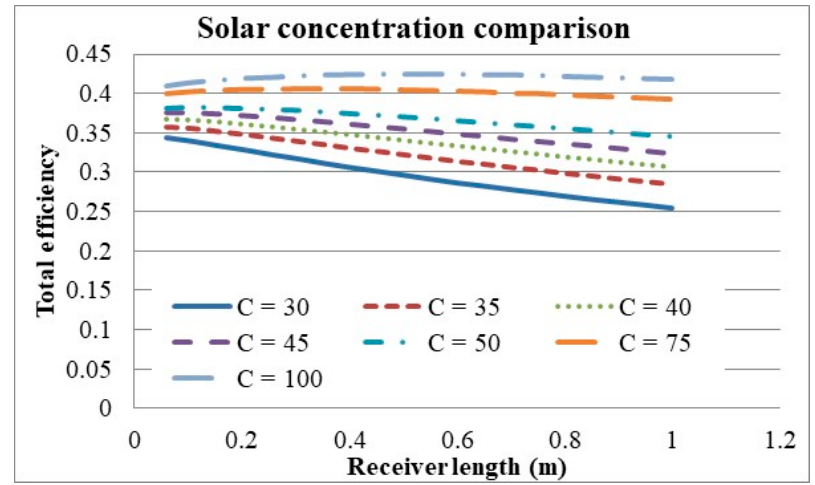
Figure 18. Solar concentration comparison at high concentrations. Table 5. Average and peak temperatures of the receiver at different receiver lengths and solar concentrations. Temperatures are in Kelvin and values exceeding the upper limit of the nanofluid